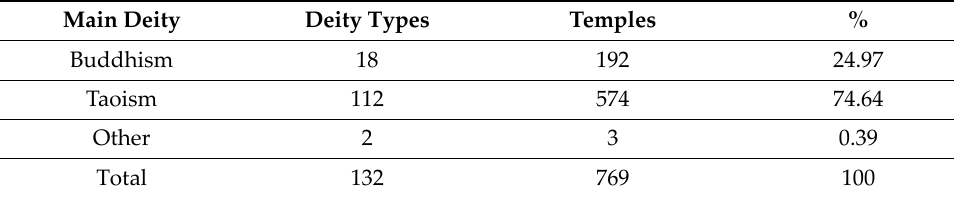
Table 11. Comparison of Buddhism, Taoism, and Other Mian Deities. Main Deity